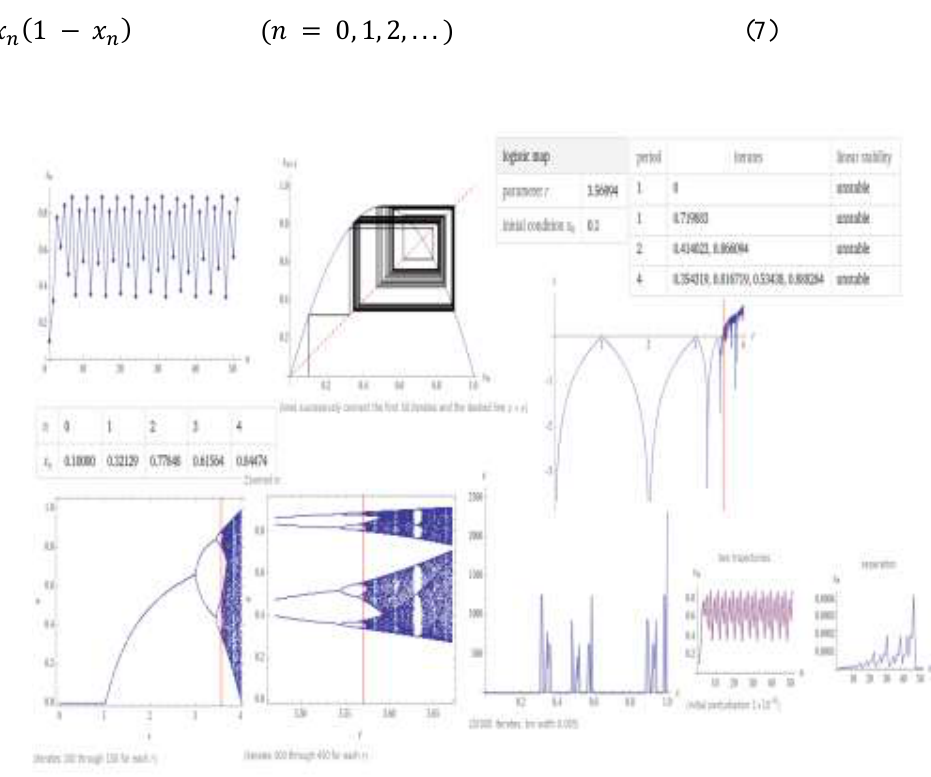
Figure 4. The first row represents the iteration of the Eq. (7) and the limiting behavior, where there is a limit cycle in the iteration 256. The second row indicates the Bifurcation diagram, which is zoomed in the iteration 300 through 450 for the value of r=3.5699. Followed by the Invariant density ρ=0.005, perpetrate trajectories and the last plot is